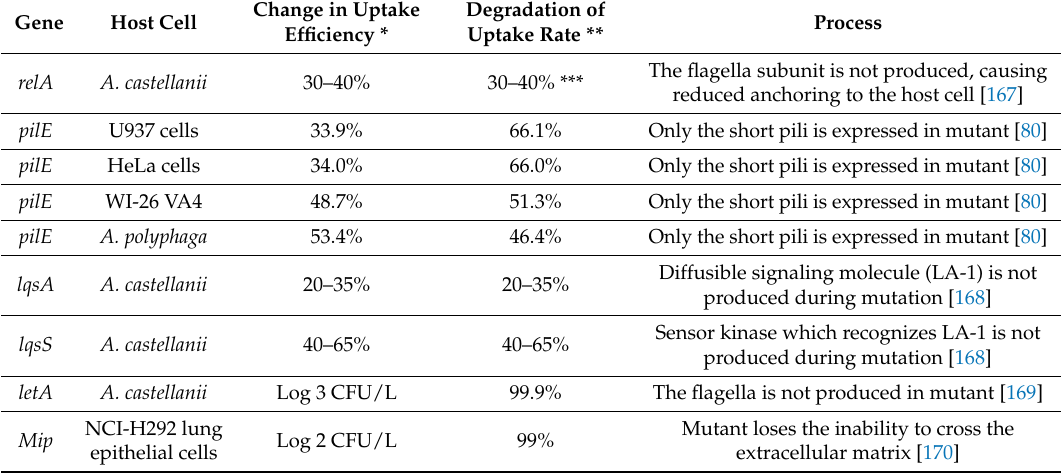
Table 1. Effects of Genetic Knockdowns on the uptake of L. pneumophila into a